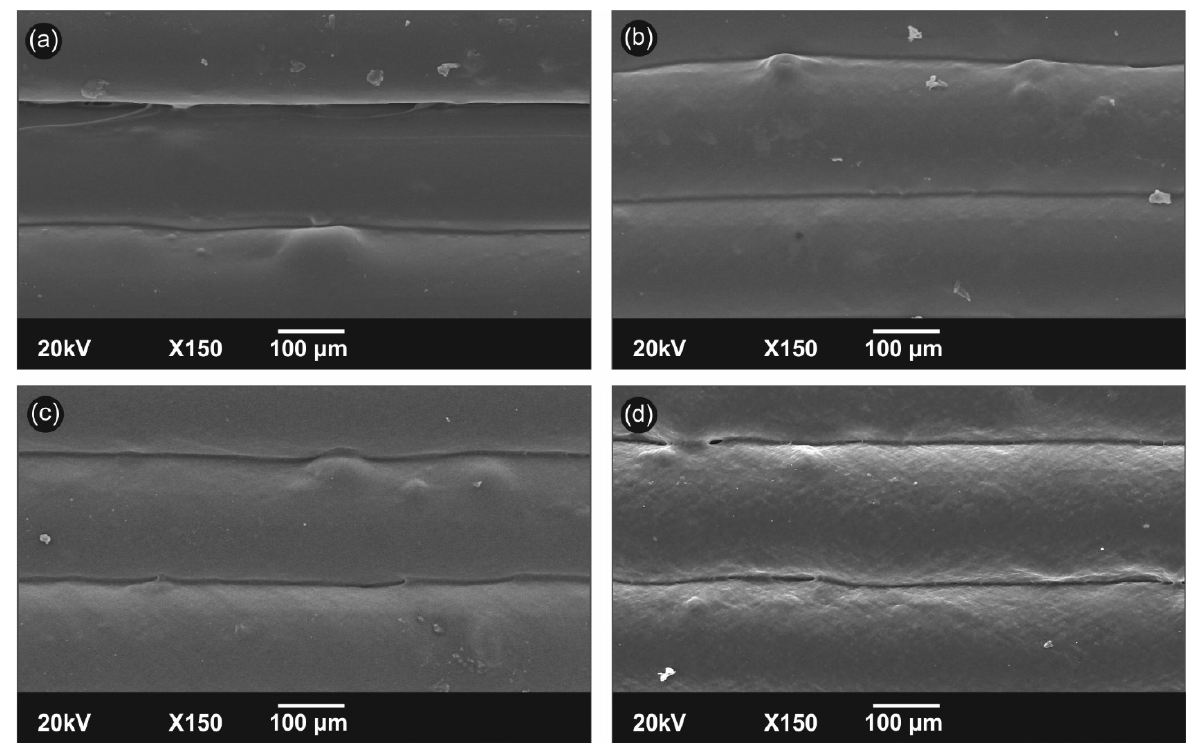
Figure 5. Side surface morphology of PA12/CNT 3D ‐ printed nanocomposites: neat PA12 ( a ), compared to 2.5 ( b ), 5.0 ( c ), and 10.0 wt.% ( d ) filler loading.